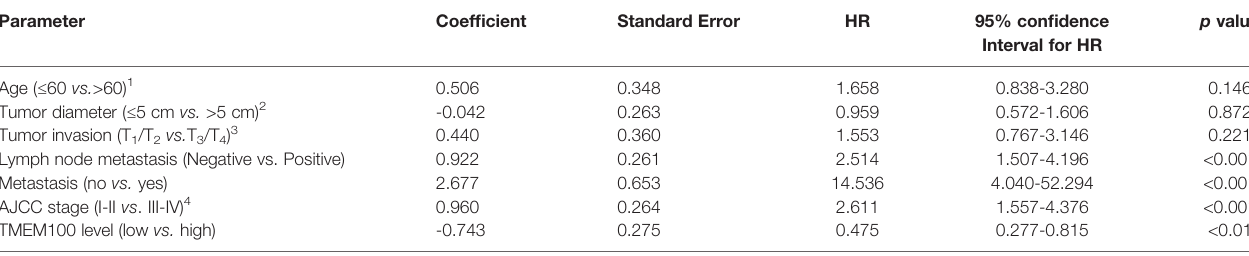
Interval for HR